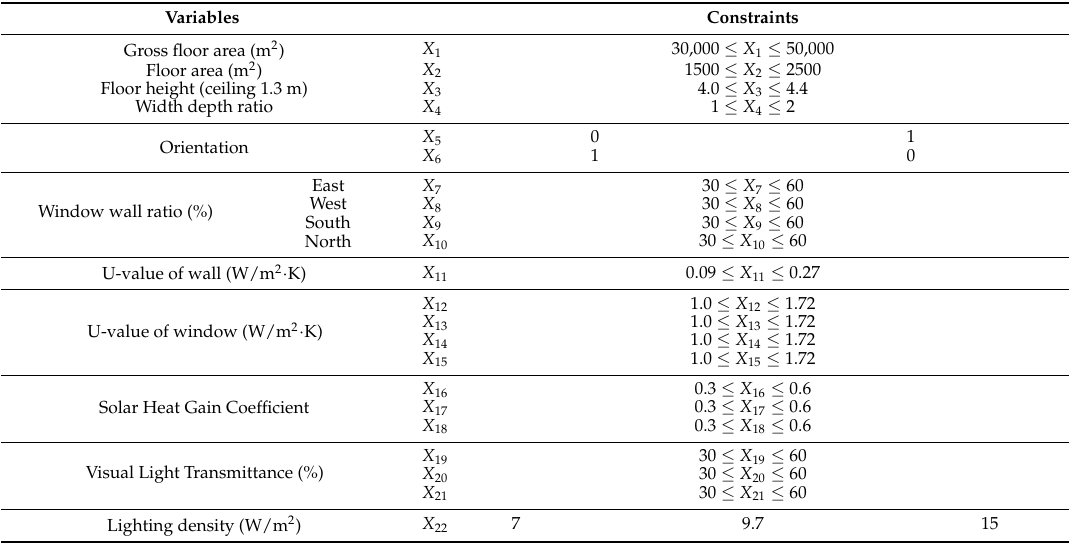
Table 10. Constraints for the selected design variables.